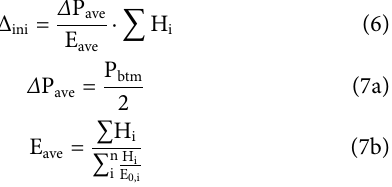
Settlement of each strata